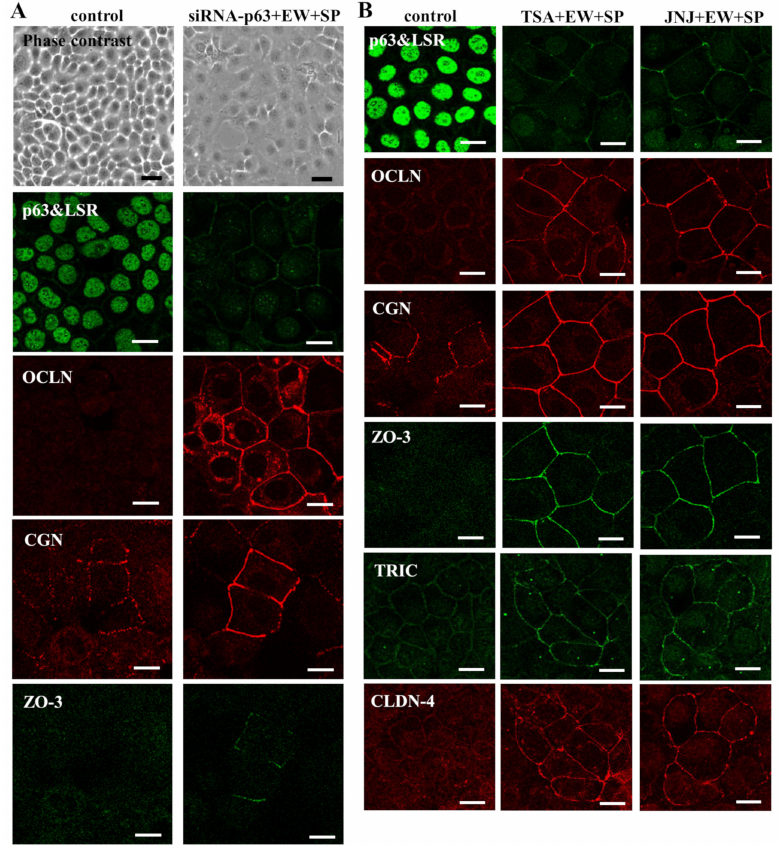
Figure 1. ( A ) Phase-contrast and immunocytochemical staining for p63, angulin-1/LSR, OCLN, CGN, and ZO-3 in A253 cells transfected with siRNA-p63 in the presence of EW-7197 and SP600125 at 10 µ M. Scale black bar: 40 µ M, white bar: 10 µ M. ( B ) Immunocytochemical staining for p63, angulin-1/LSR, OCLN, CGN, ZO-3, TRIC, and CLDN-4 in A253 cells treated with TSA and JNJ at 10 µ M in the presence of EW-7197 and SP600125 at 10 µ M. Scale bar: 10 µ